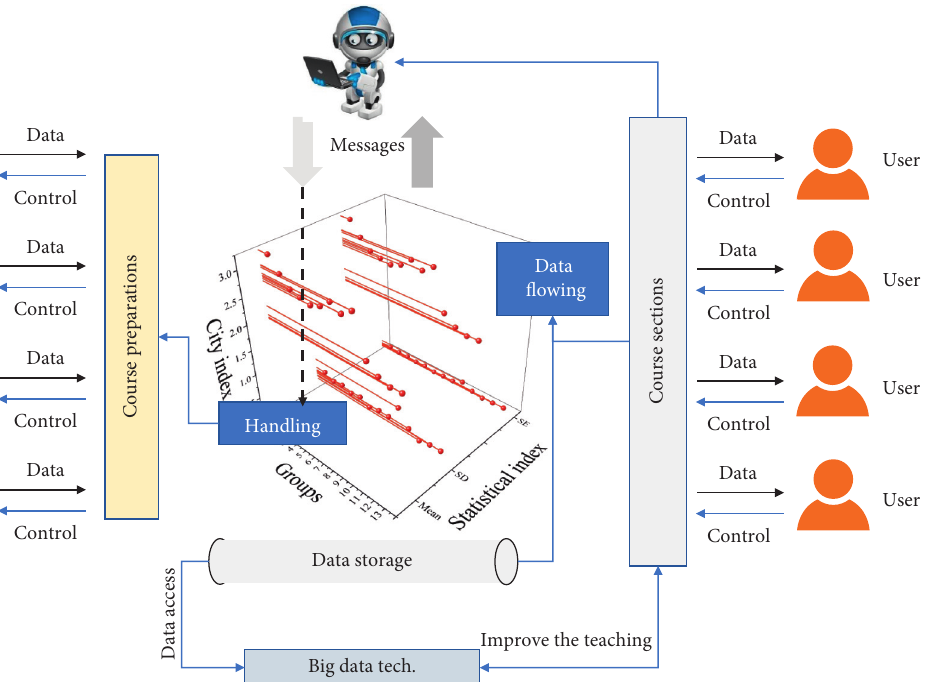
Figure 1: Clustering analysis